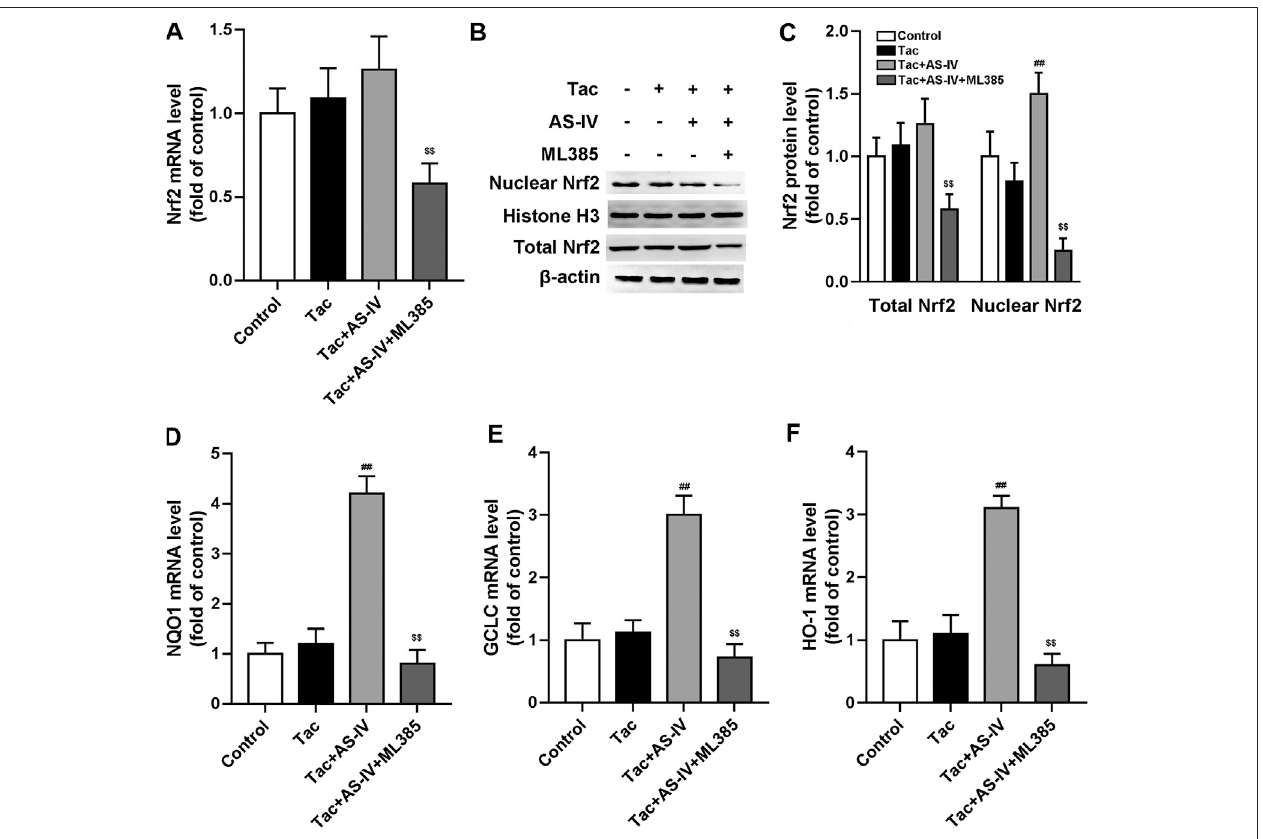
FIGURE 5 | ML385 inhibited Astragaloside IV-induced Nrf2 nuclear translocation and down-stream genes transcription in HK-2 cells. The HK-2 cell were pretreatedwithAS-IV(50 µM)withorwithoutML385(3 µM)for30 min.Thentacrolimuswasaddedintothecellsfor24 h (A) TheNrf2mRNAinHK-2cellsweretestedby RT-qPCRassay( n (cid:1) 8) (B – C) ThenuclearNrf2andtotalNrf2proteinofHK-2cellweredetectedbyWesternblotting( n (cid:1) 6).ThemRNAlevelsofNQO1 (D) ,GCLC (E) and HO-1 (F) were evaluated by RT-qPCR ( n (cid:1) 8). ## p < 0.01 vs. the Tac group; $$ p < 0.01 vs. the Tac + AS-IV